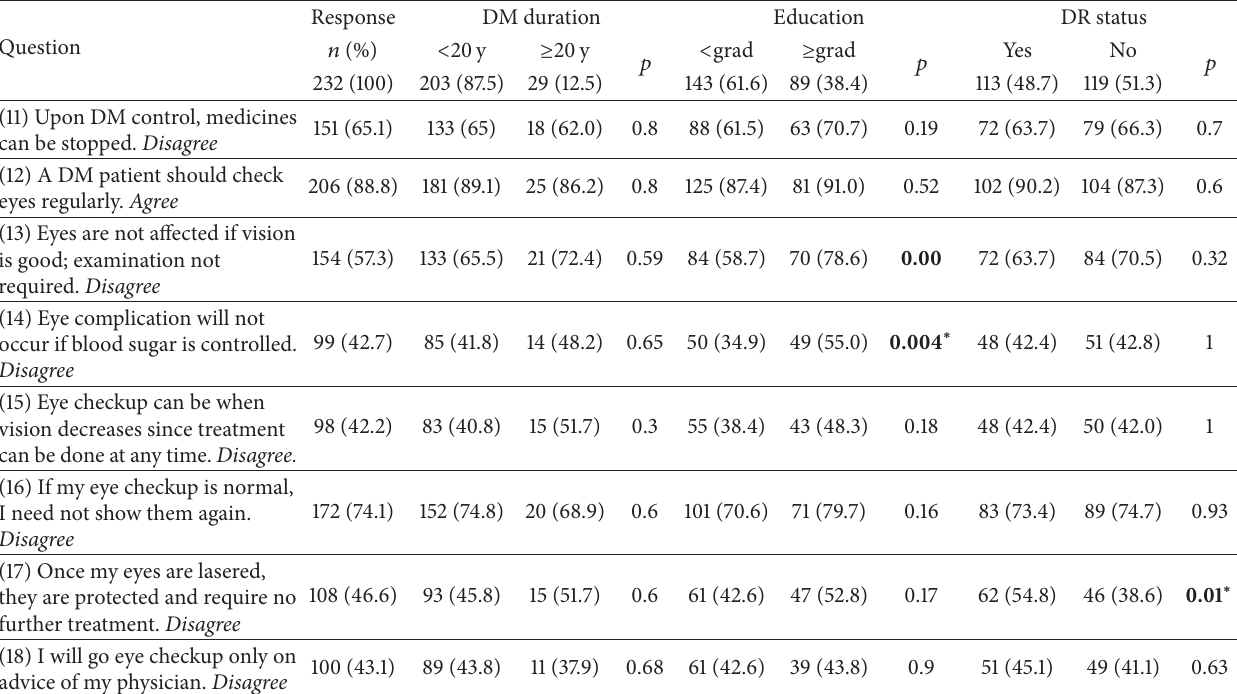
Table 3: Patient response and subgroup analysis of attitude